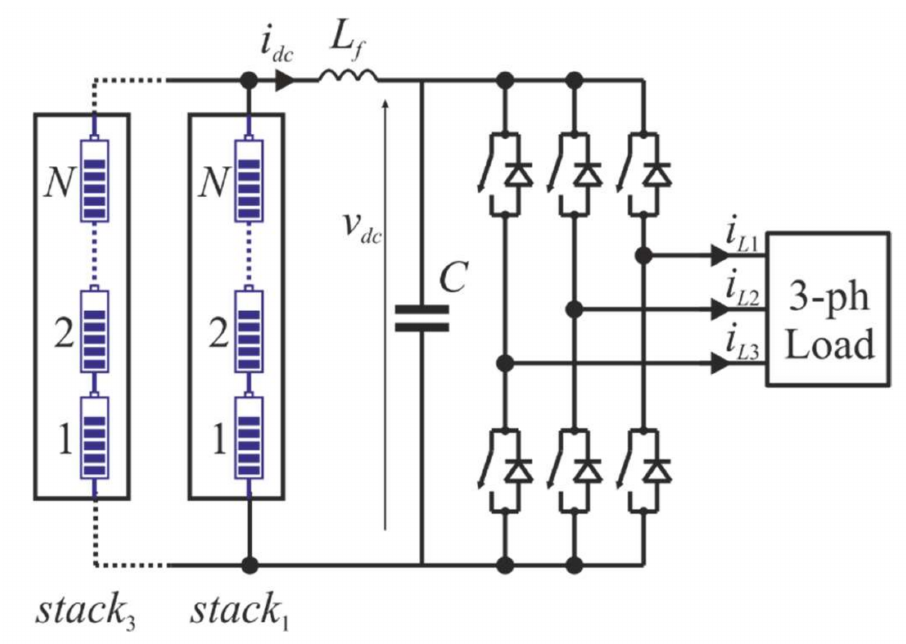
Figure 3. Voltage Source Inverter